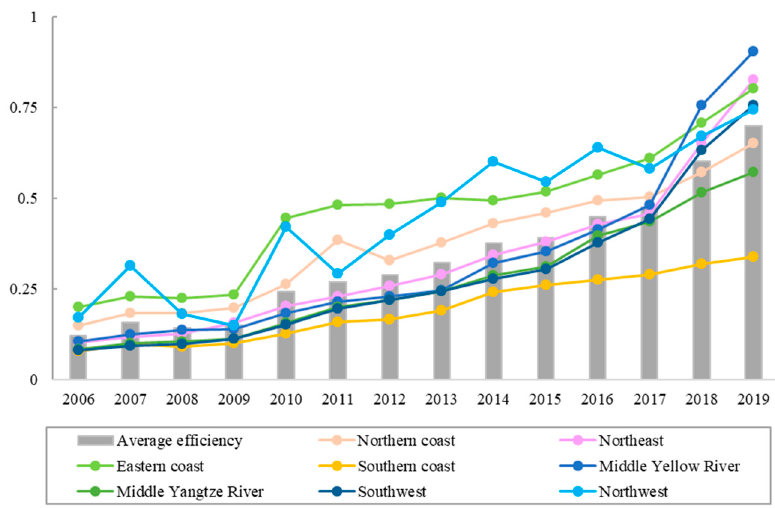
Figure 2. Changes in tourism efficiency in eight regions.